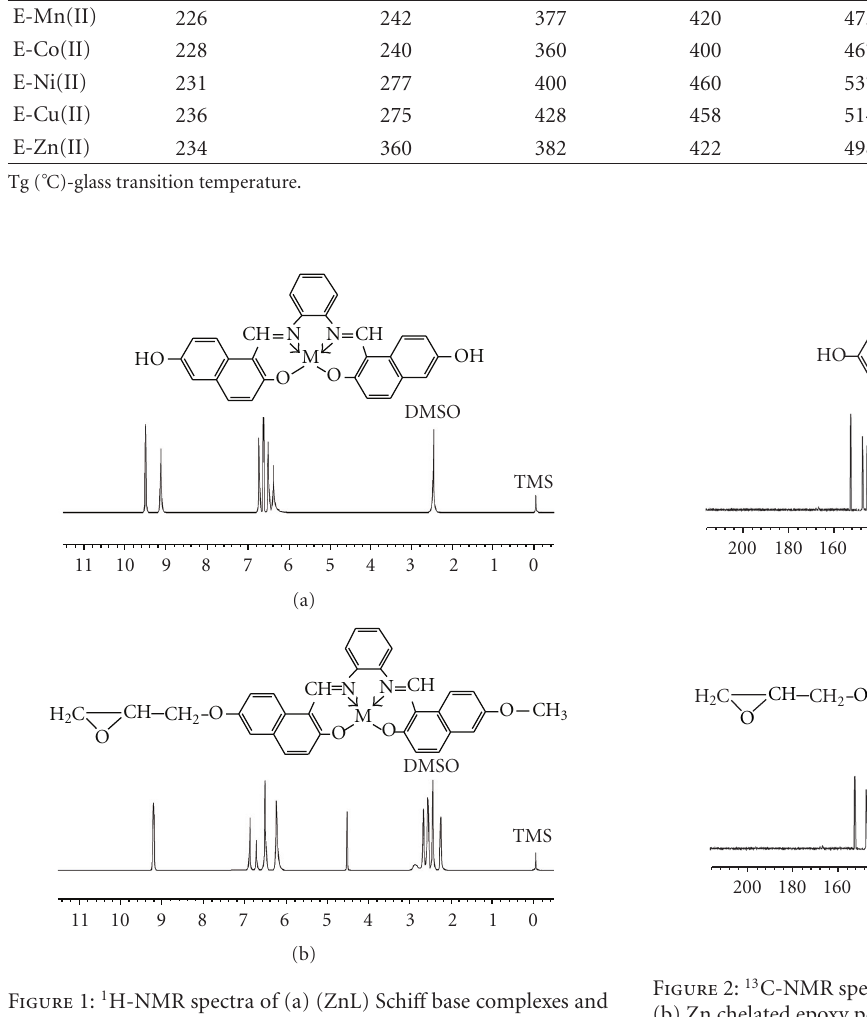
Figure 1: 1 H-NMR spectra of (a) (ZnL) Schi ff base complexes and (b) Zn chelated epoxy polymers.